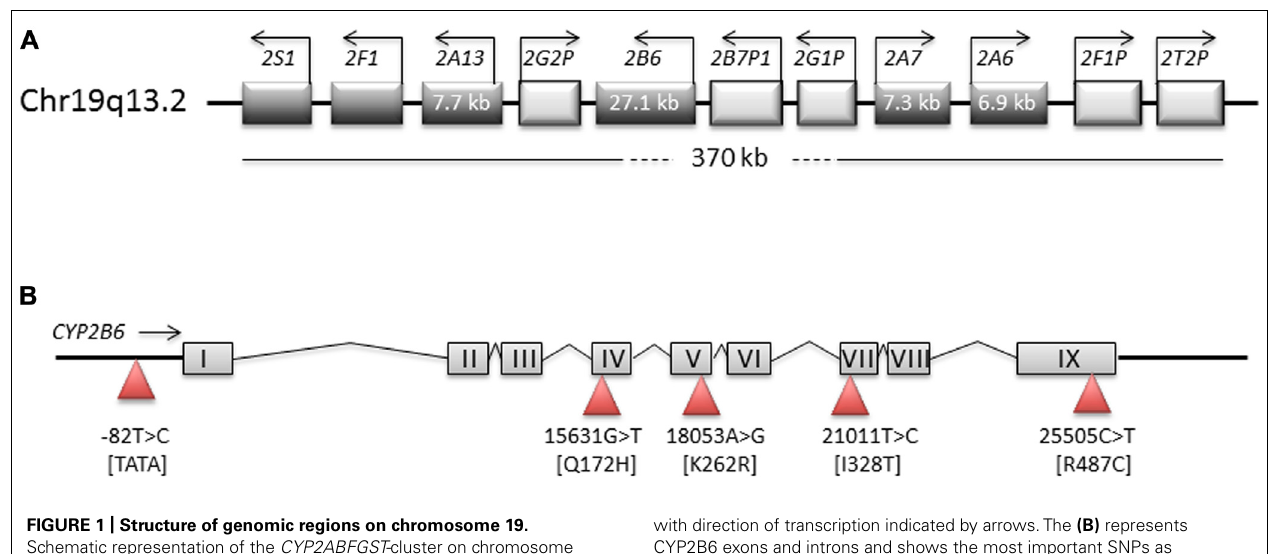
FIGURE 1 | Structure of genomic regions on chromosome 19. Schematic representation of the CYP2ABFGST- cluster on chromosome 19 (A) and of the CYP2B6 gene (B) . Boxes in the (A) represent genes,